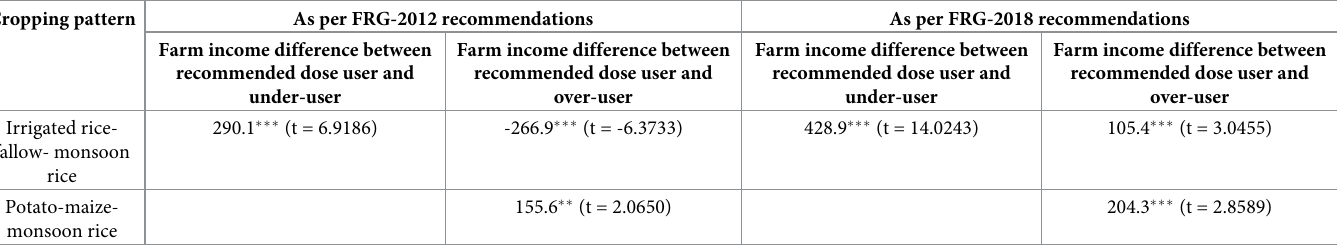
Table 6. Farm income (USD ha -1 ) difference among different levels of nutrient users in crops relative to government-endorsed recommendations under diverse rice-based cropping patterns. Cropping